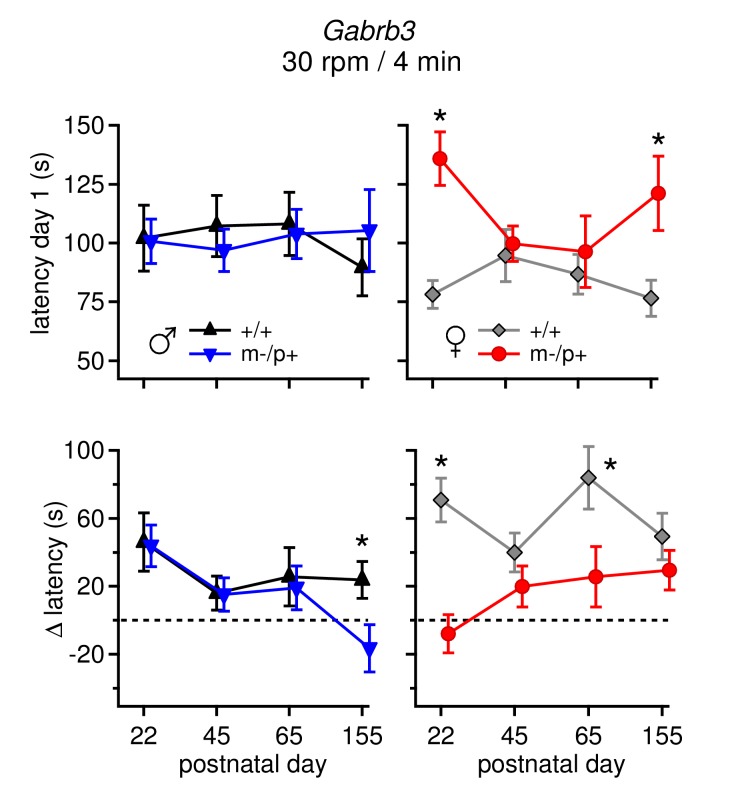
Differences in performance on rotarod change over development.(Top: ) Average latency to fall on Day 1 for all four age groups for males (left) and females (right). Only m-/p+ females showed variable day 1 latencies throughout development. (Bottom: ) Average Δ latency for all four age groups for males (left) and females (right). Mutant males showed a decreasing Δ latency over development, whereas mutant females showed a increasing Δ latency over development. For all groups (sex, mutation, age), n=8.